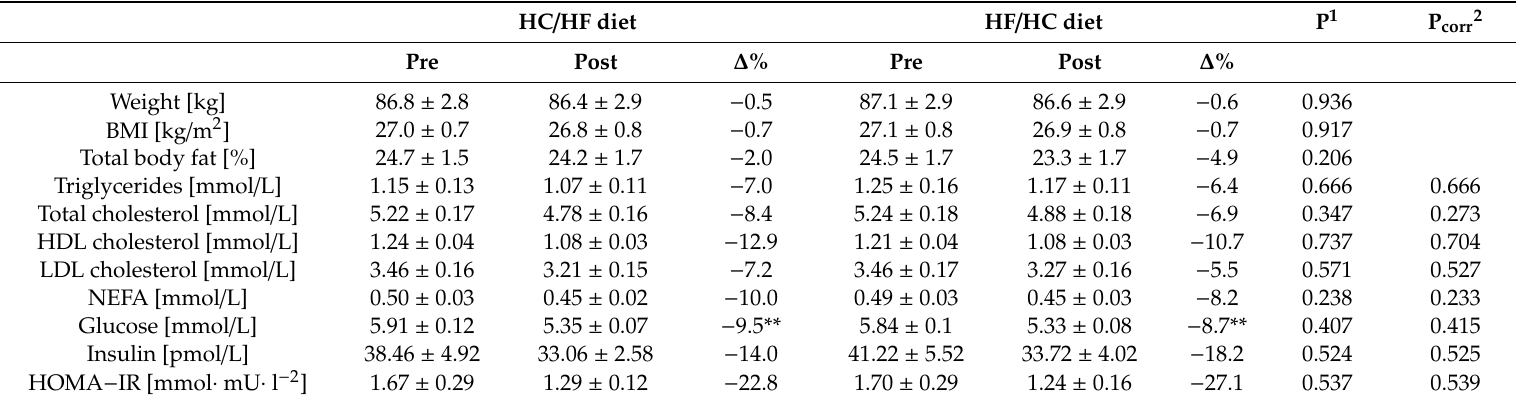
Table 1. Fasting parameters in response to the